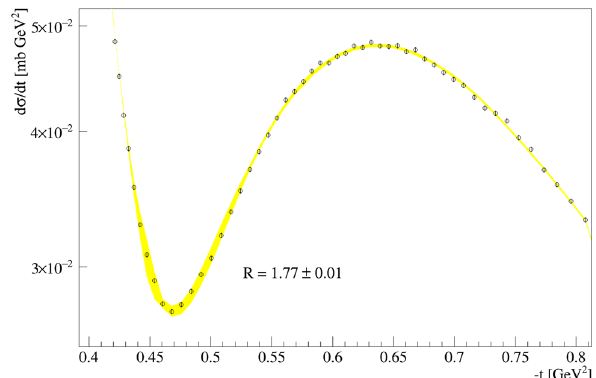
Fig. 9 Summary of the | t | -dependent systematic uncertainties. The figure shows the systematic uncertainties due to 1 σ optics, alignment and beam momentum perturbations. The contribution of the unfolding into the systematic uncertainty is also presented. The yellow band is the combined systematics uncertainty